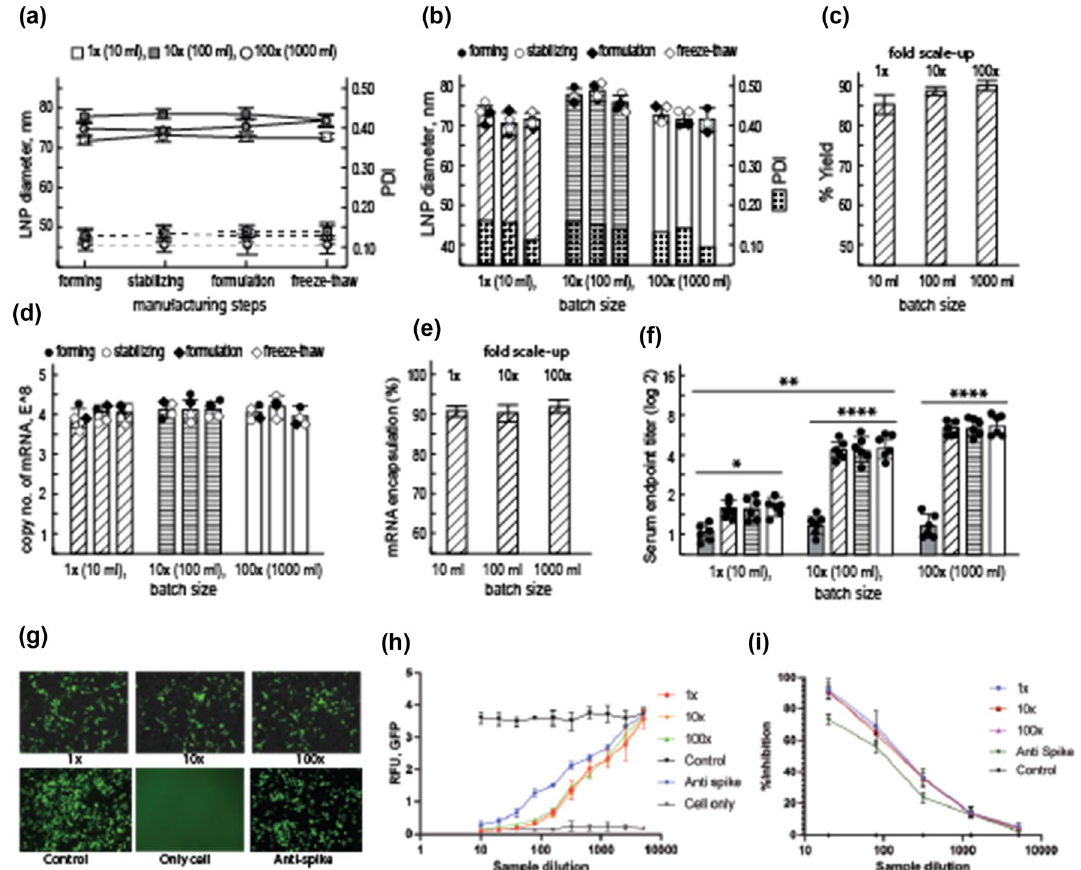
Figure 3. Characterization of the method for scale-up process and evaluation of the bioequivalency of doses obtained from scale-up process. ( a ) The sizes of LNPs do not change during different steps of dose manufacturing and handling; solid line, LNP size and dotted line, relevant PDI values. ( b ) The changes in LNP size for each steps are shown for individual batch for all 3 batch sizes and found non-significant. Relevant PDI values are shown at the bottom in dark shade. ( c ) The yield for different sizes of batches. ( d , e ) Copy numbers of mRNA and mRNA encapsulation efficiency in LNP for different size batches, respectively. Data were analyzed using one-way ANOVA and found non-significant; n = 4 for all experiments of ( a – e ). ( f ) Antibody titer in response of vaccination in rabbits from 3 different size batches ( n = 6); data were compared by Mann– Whitney test, **** p value < 0.0001, *** p value < 0.001, ** p value < 0.01, * p value < 0.05. ( g ) Neutralization of GFP-expressing SARS-CoV-2 pseudovirus in ACE2-expressing HEK cells by vaccinated sera (1 ×, 10 × and 100 × represents vaccines manufactured from different batch sizes). The data shown here is from 640 × dilution of sera. Compare with a commercially available anti-spike antibody all vaccinated sera showed reduced number of GFP-positive cells ( n = 4). ( h ) The neutralization curve shows the immunized rabbit sera outclassed the commercial SARS-CoV-2 antibody with no significant differences for 3 different size batches ( n = 4); the IC 50 values were found at 480 ± 30 × dilutions. ( i ) HIV1-based SARS-CoV-2 pseudovirus neutralization by vaccinated sera was evaluated by RT-PCR ( n = 4); the IC 50 values were found at 280 ± 40 × dilutions and superior than the commercial